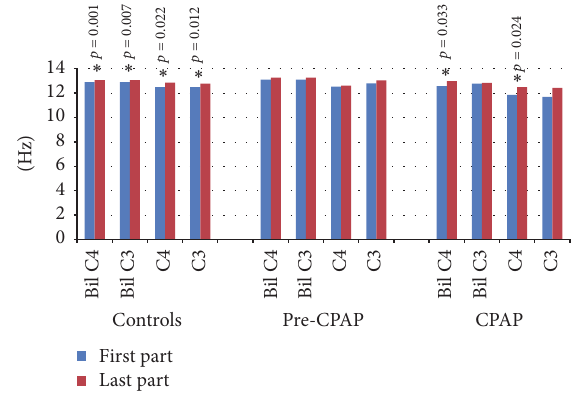
Figure 4: Frequency of the central spindles in the first and last part of the NREM sleep in the study groups. The statistically significant differences are marked with an asterisk and denoted with the 𝑝